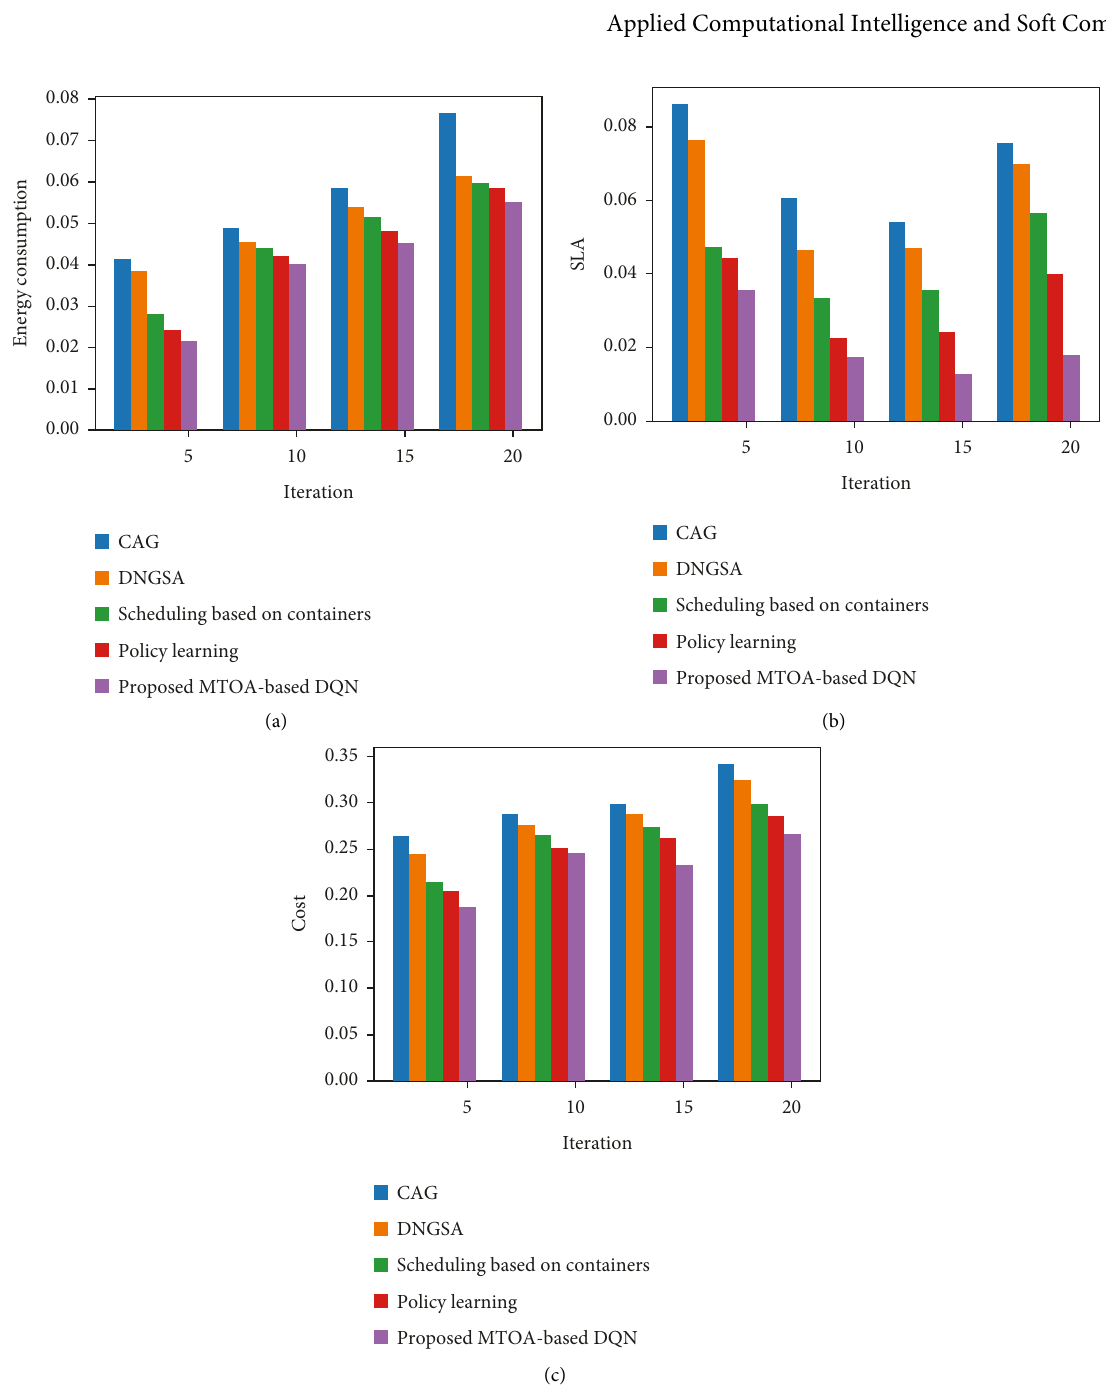
Figure 5: MTOA-based DQN with 625VM using fast storage data: (a) energy consumption, (b) SLA, and (c)